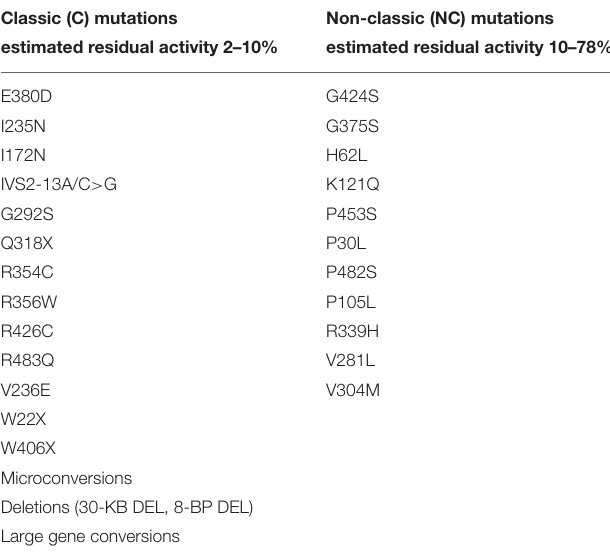
TABLE 1 | Mutations of CYP21A2 with minimal (C) or moderate (NC) residual enzyme activity (14, 68,